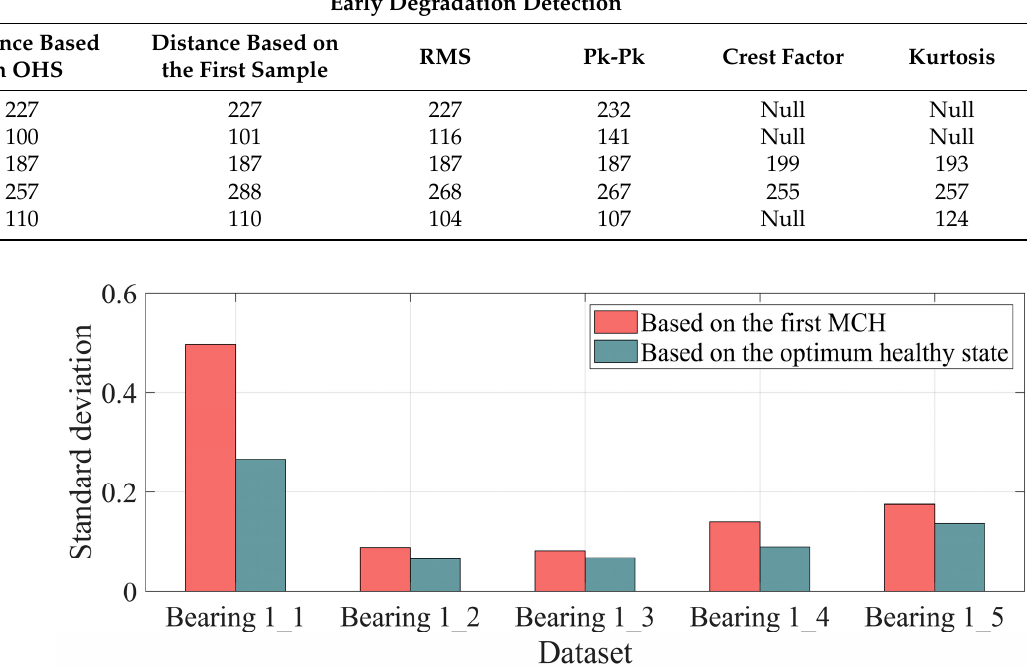
Figure 8. The standard deviation of distance curves in the healthy stage based on various base- lines.